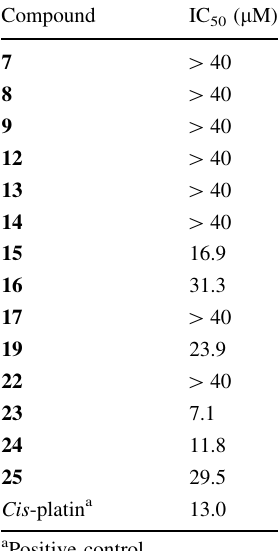
Table 3 Cytotoxicities of compounds 7 – 9 , 12 – 17 , 19 , and 22 – 25 against MCF-7 tumor cell line with IC 50 ( l